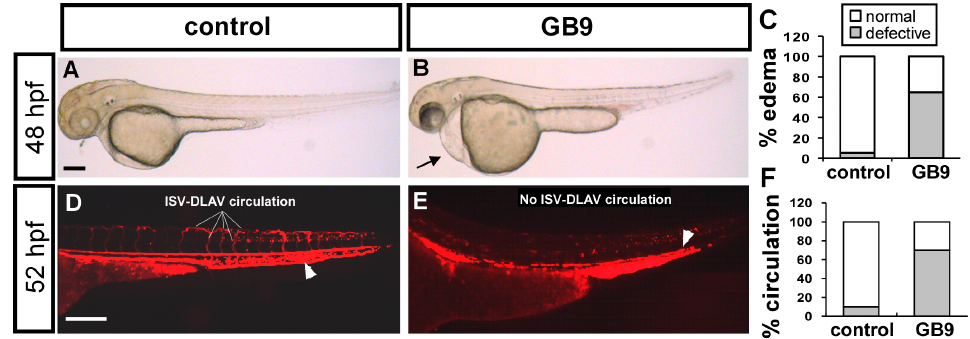
Figure 3. Pericardial edema and circulation defect in GB9 treated embryo. ( A – C ) At 48 hpf, representative edema fish ( arrow in ( B )) and quantitative results showed 60% of GB9 treated embryo ( n = 20) with mild to severe pericardial edema compared to untreated control ( n = 19). ( D , E ) GB9 treatment in transgenic Tg ( gata1:dsRed ) embryos with dsRed-labeled blood cells showed slow to no circulation at 52 hpf ( E ) compared to wild-type fish ( D ). ( F ) Circulation defects at the ISV/DLAV or slow to lose axial circulation of the aorta/vein in the trunk region are quantified in control ( n = 18) and GB9 treated embryo ( n = 18) at 52 hpf. The scale bar in ( A , B ) is 500 µ m, and in ( D , E ) represents 200 µ m. 2.3. Vascular Defects in GB9-Treated Embryos Are Likely Due to the Impairment of Proliferation and/or Migration of Endothelial